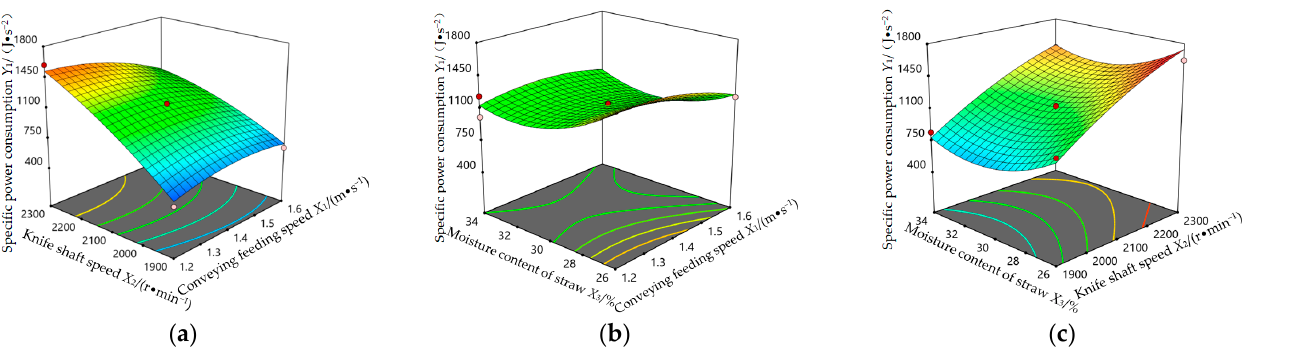
Figure 13. Response surface of interaction factors to specific power consumption. ( a ) Specific power consumption response surface under factors X 1 and X 2 ; ( b ) Specific power consumption response surface under factors X 1 and X 3 ; ( c ) Specific power consumption response surface under factors X 2 and X 3 .